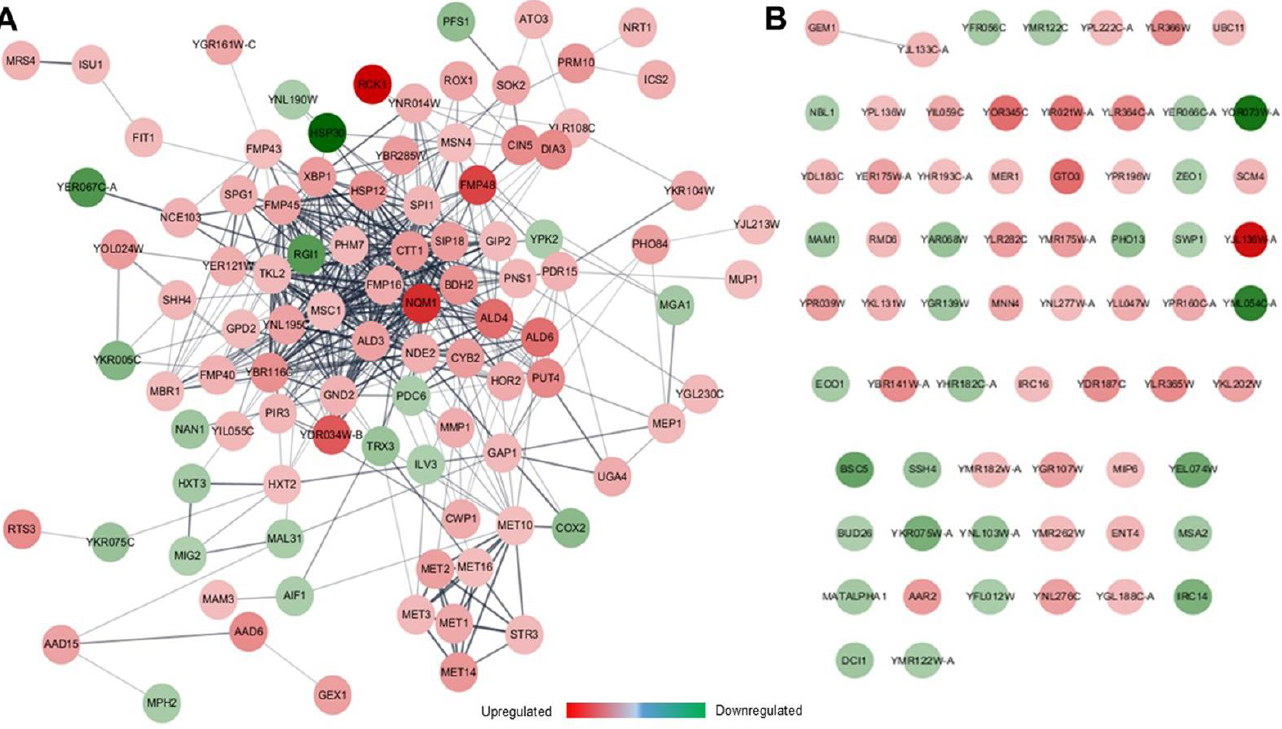
Figure 6. StringGO-based genetic network of multiple genes ( A ) and single gene ( B ) of twofold changed genes in DaMDHAR -expressing yeast cells under repeated FT (FT2) stress.